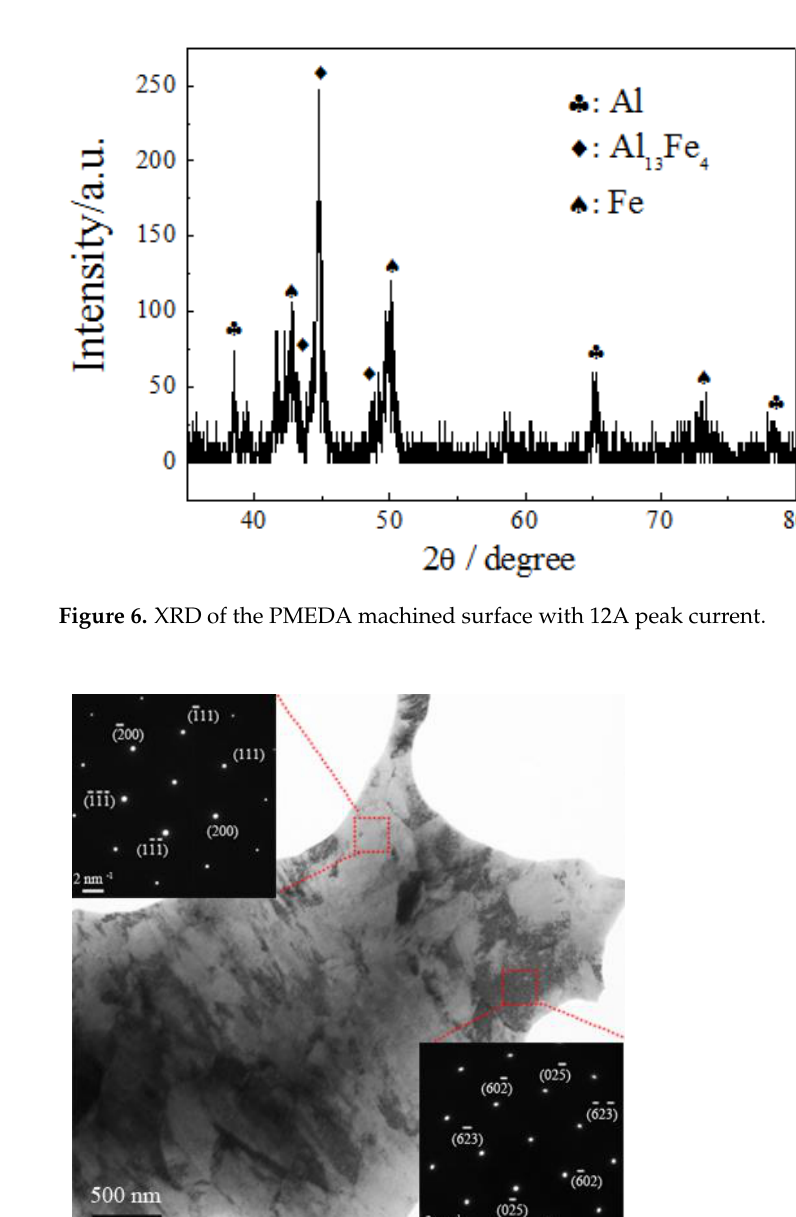
Figure 7. Bright-field TEM image of top surface of the EDA machined surface with 6A peak current, the inset is the selected area electron diffraction patterns of the red box area, demonstrating the existence of Al 13 Fe 4 phase (lower right) and Fe phase (upper left).